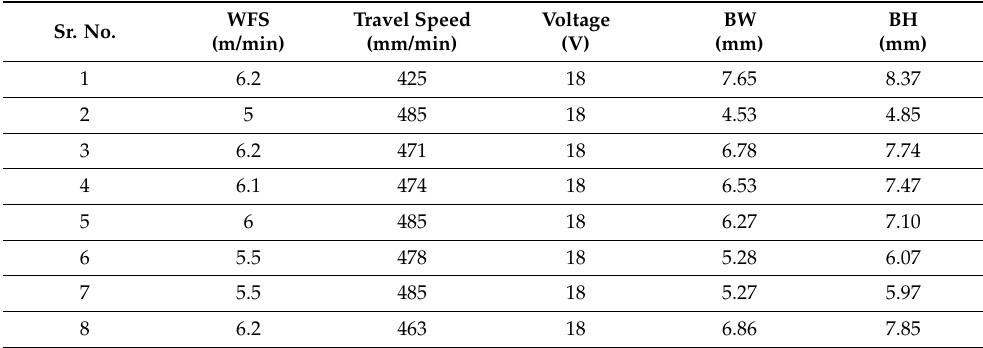
Table 7. Non-dominated unique solutions obtained from